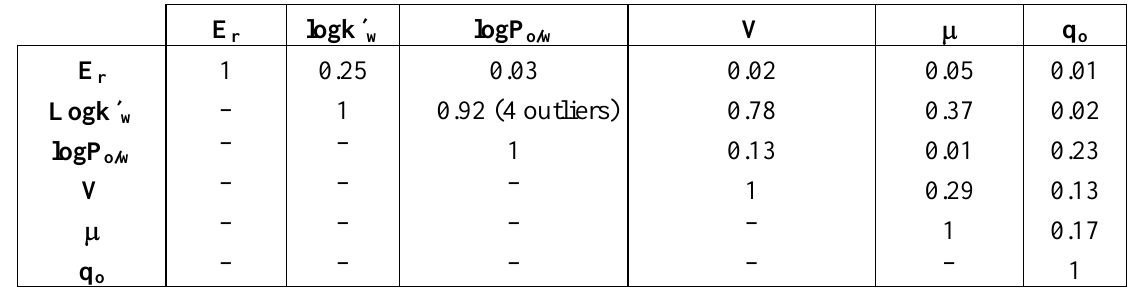
Table 3 : Correlation matrix for the used physicochemical descriptors